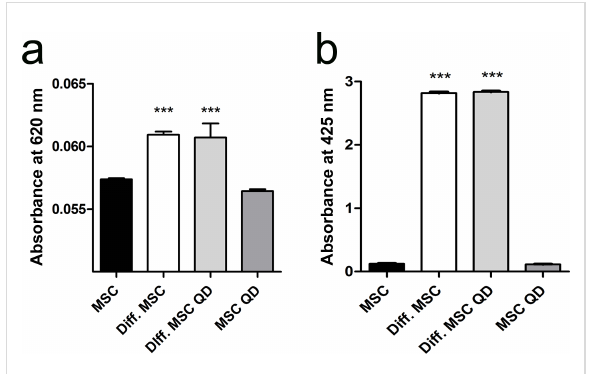
Figure 6: Quantification of osteogenesis and chondrogenesis in MSCs. Absorbance of Alizarin Red S (a) and Alcian Blue (b) extrac- tion from MSC differentiation. Diff. MSC: differentiated MSCs, diff. MSC QD: differentiated MSCs labelled with QDs. Significance com- pared between differentiated and undifferentiated samples; ***p-value < 0.001.